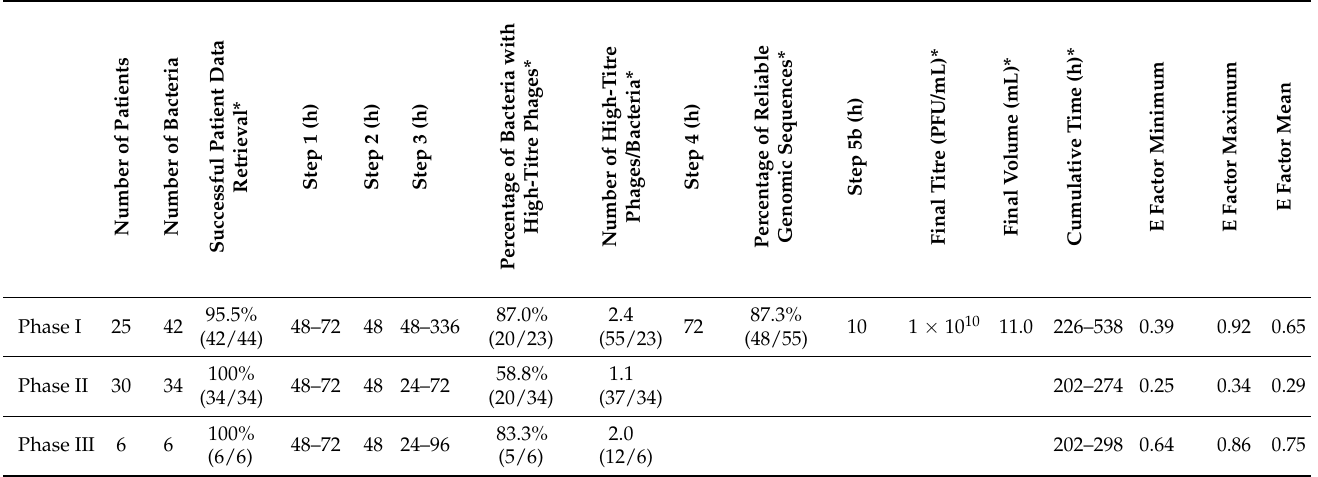
Table 1. Efficiency calculation. Time, in hours, indicates hands-on time, transfer time between different institutes, and inevitable waiting periods. Transfer time to the next institute is counted to the respective previous step. Step 1–5a: Steps of the pipeline, see Figure 1. E factor minimum/maximum: efficiency factor, calculated using Equation (1), considering the minimal/maximum cumulative time. E factor mean: mean efficiency factor, calculated using minimum and maximum E factor. Phases I and II focused only on steps requiring optimization, and the results of the standardized steps 4 and 5b of phase I were considered for E factor calculation. Parameters with an asterisk * are integrated into Equation